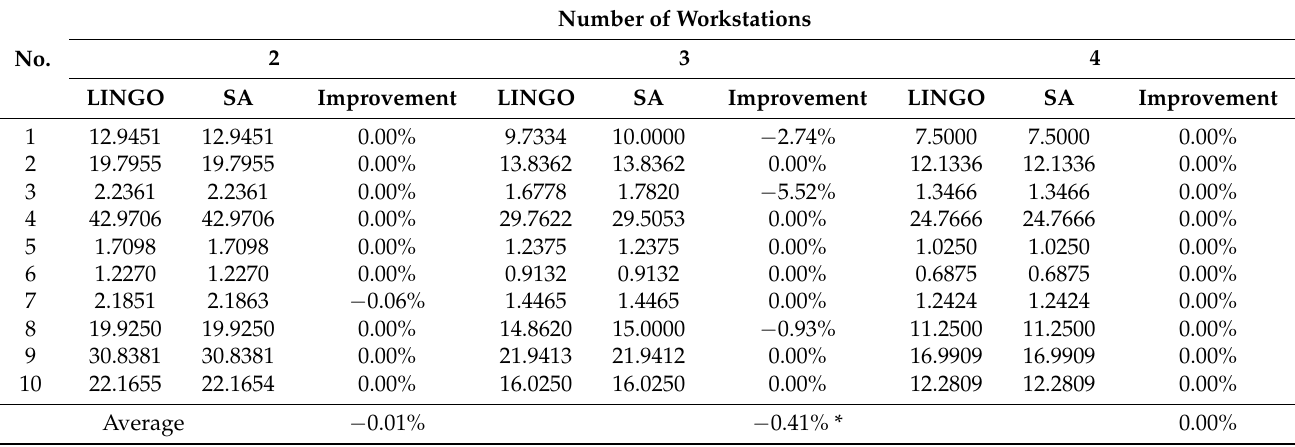
Table 2. The cycle times of experimental results for small problems ( b = 10% of length of the conveyor).